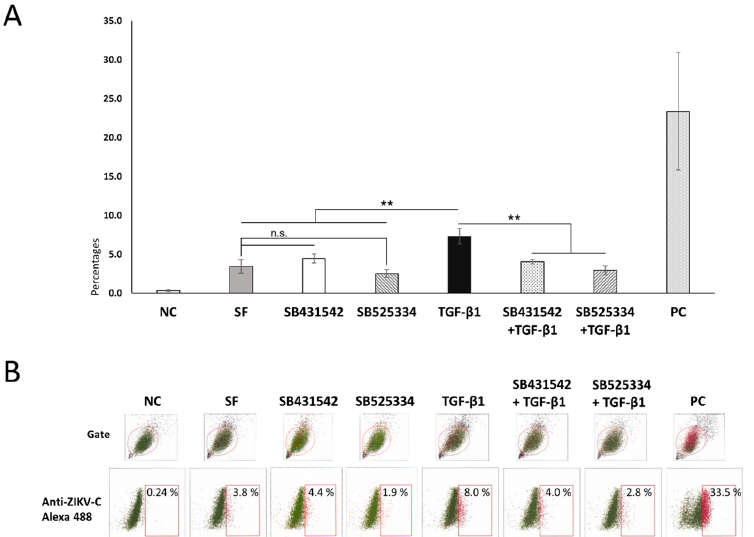
Figure 3. Percentages of the studied trophoblast Swan.71 cells positive for ZIKV as determined by FCM analysis at 24 hpi. ( A ) Mock-infected cells using a culture medium were used as negative controls (NC). Vero cells infected with ZIKV performed in parallel were used as positive controls (PC). The results are expressed as the mean of at least triplicate experiments in each group, and the graph is representative of three independent experiments. n.s., not significant; **, p < 0.01. Representative images of FCM analysis. ( B ) Numbers displayed inside each panel correspond to the percentage of the cells positive for ZIKV capsid protein of the parent-gated population.